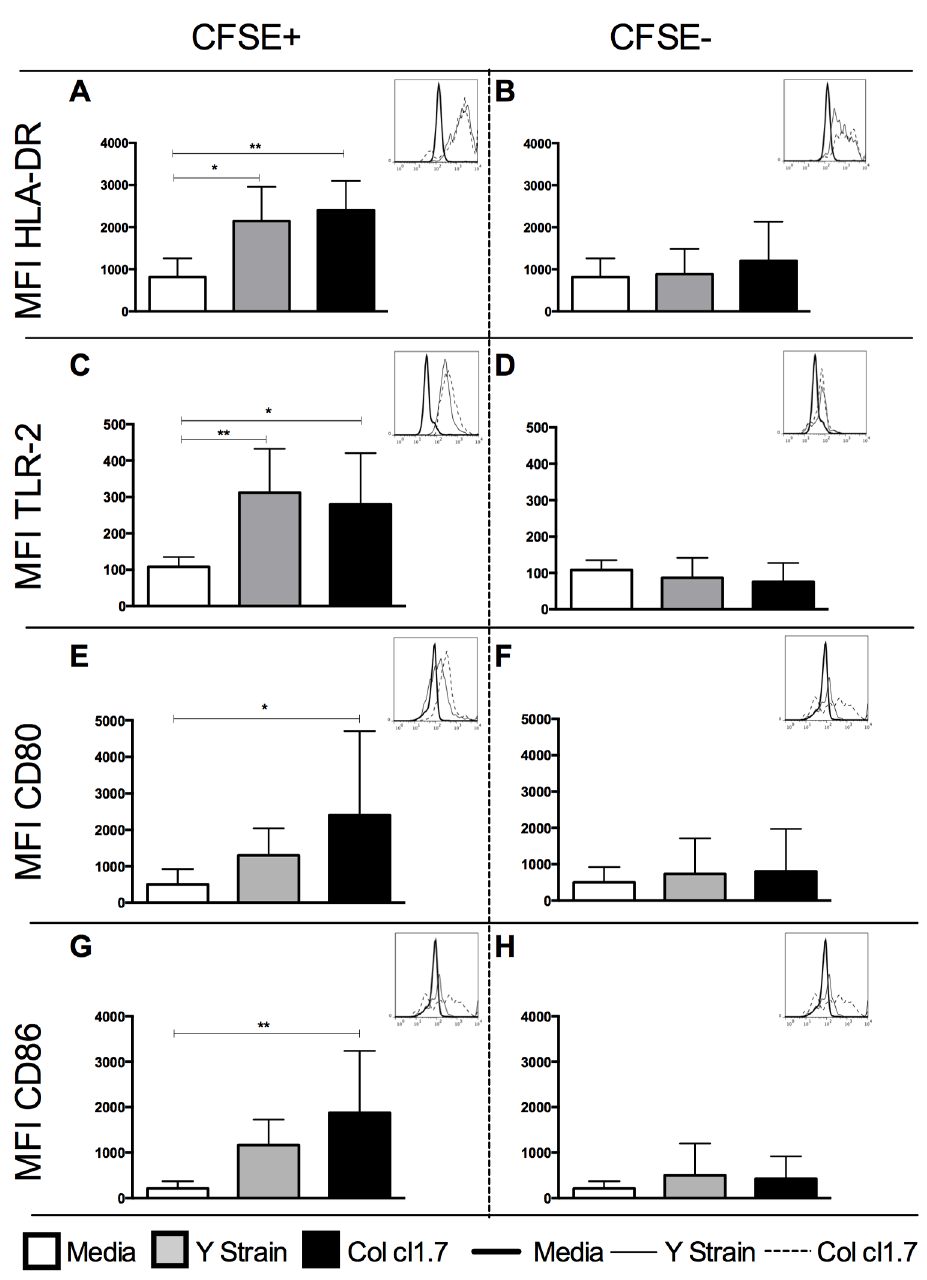
Fig 2. Determination of the MFI of HLA-DR, TLR-2, CD80 and CD86 in human monocytes infected or not with strains of T . cruzi . Results are expressed as average ± standard deviation. The symbol * indicates p < 0.05 between groups. Determination of mean intensity of (A) HLA-DR in CFSE+ monocytes after 15 hours of culture; (B) HLA-DR in CFSE- monocytes after 15 hours of culture; (C) TLR-2 in CFSE+ monocytes after 15 hours of culture; (D) TLR-2 in CFSE- monocytes after 15 hours of culture; (E) CD80 in CFSE+ monocytes after 72 hours of culture; (F) CD80 in CFSE- monocytes after 72 hours of culture; (G) CD86 in CFSE + monocytes after 72 hours of culture; (H) CD86 in CFSE- monocytes after 72 hours of culture. Histogram inserts show a representative overlay for the expression of each of the molecules under the different